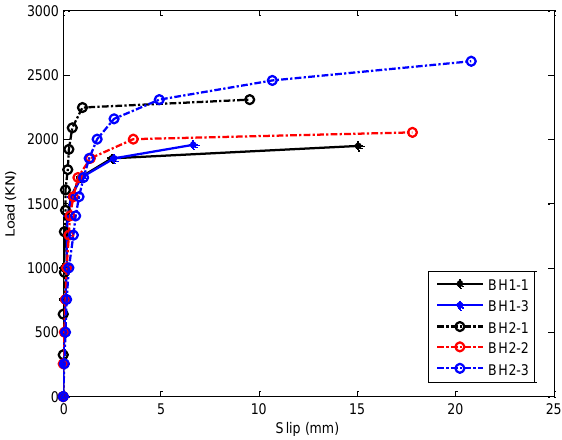
Figure 16. Load–slip